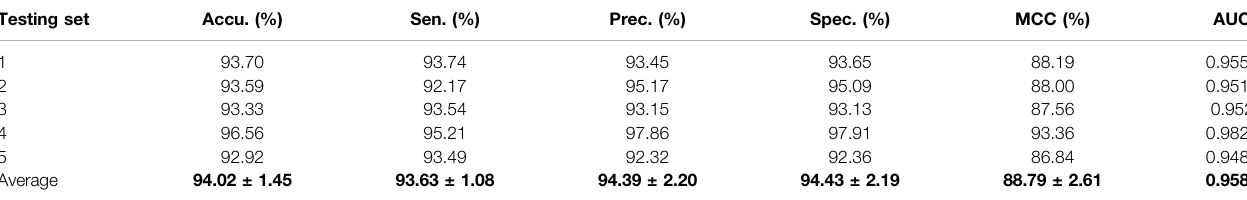
TABLE 3 | The fi vefold cross-validation results achieved on the Oryza sativa dataset using the proposed CPIELA method. Testing set Accu. (%) Sen.